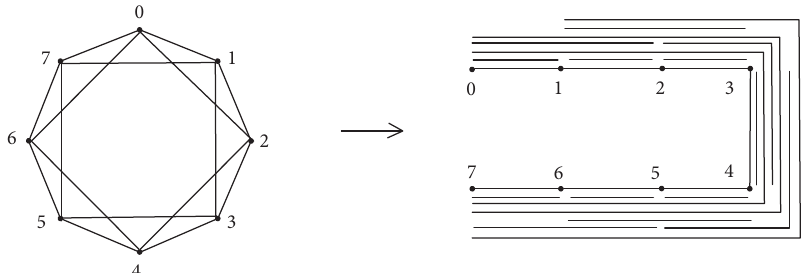
Figure 1: The correct layout of the embedding circulant network into path by μ ( x ) � x